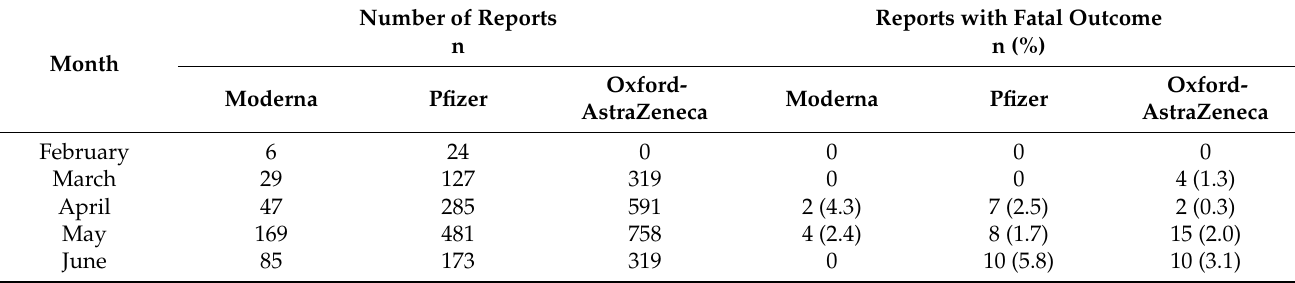
Table 2. Monthly distribution of thromboembolic EV reports for the three vaccines from 17 February to 14 June 2021.